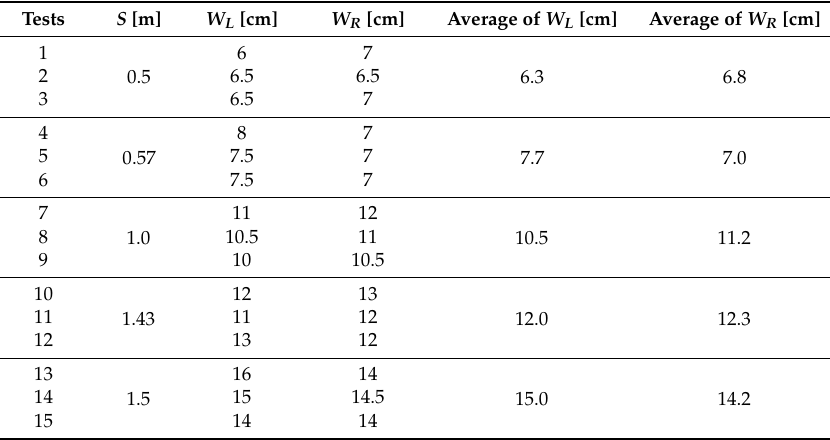
Table 2. Results of beam width experiments.